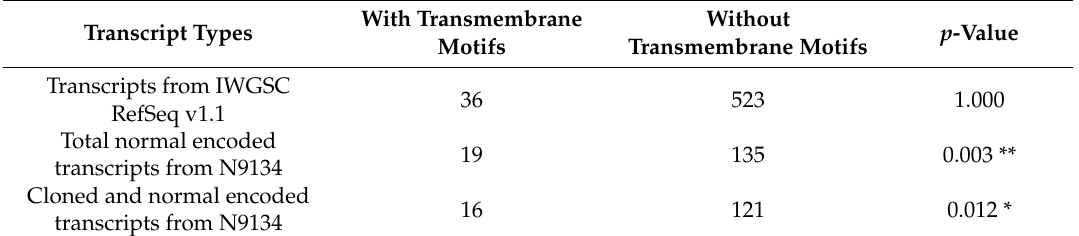
Table 4. Conformity test between number of TaNAC transcripts with or without transmembrane motifs in N9134 and that in IWGSC RefSeq